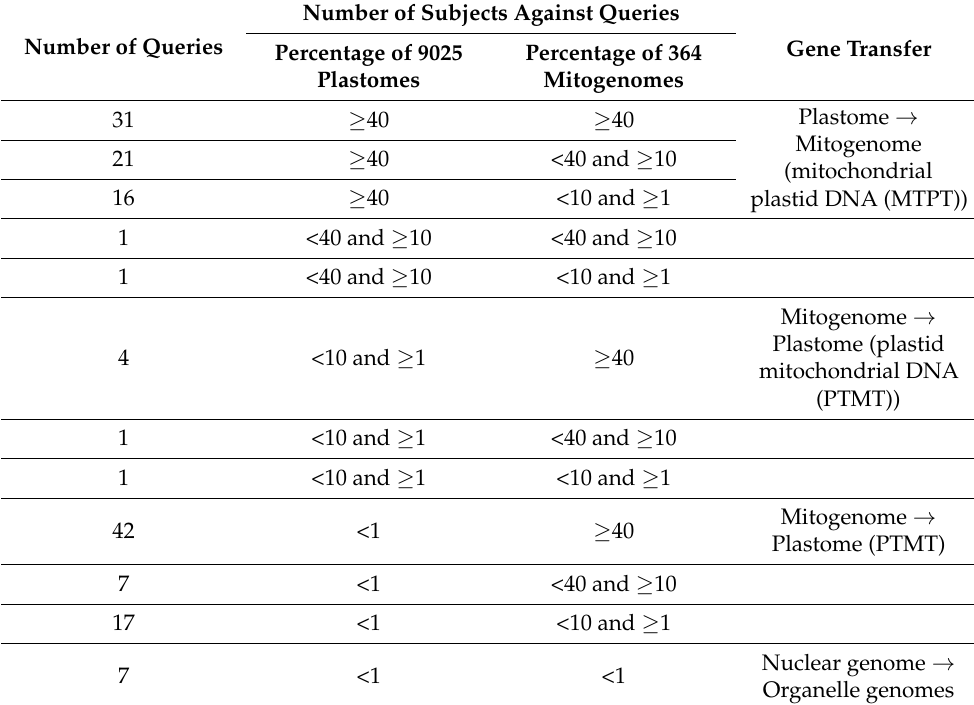
Table 3. Number of organelle genomes against 149 regions in the mitogenome of V. sambucifolium f. dageletiana that corresponded to sequences in the plastomes of terrestrial